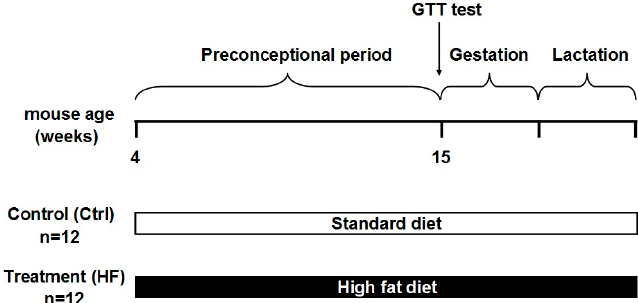
Figure 1. Experimental design. Kunming females were fed a standard or a high-fat diet throughout the whole experiment. Glucose tolerance tests were performed before mating.